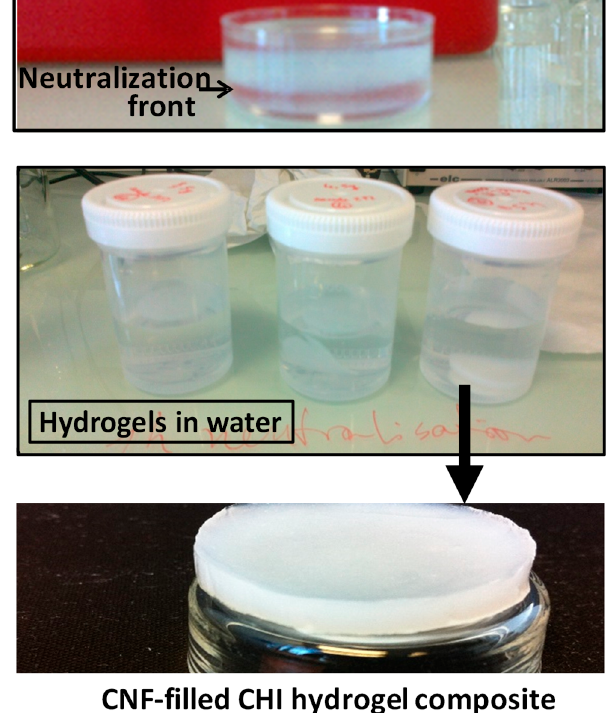
Figure 4. Images of the material appearance during the different steps of the processing of CNF-filled CHI composite hydrogels. (Top) Neutralization of a CNF/CHI viscous suspension with aqueous NaOH, showing the neutralization front which moves with time from the top to the bottom of the Petri dish. (Middle) Three examples of flat composite hydrogels (2% CHI/0.2% CNF ( w / w )) preserved in distilled water after finalized the washing steps.